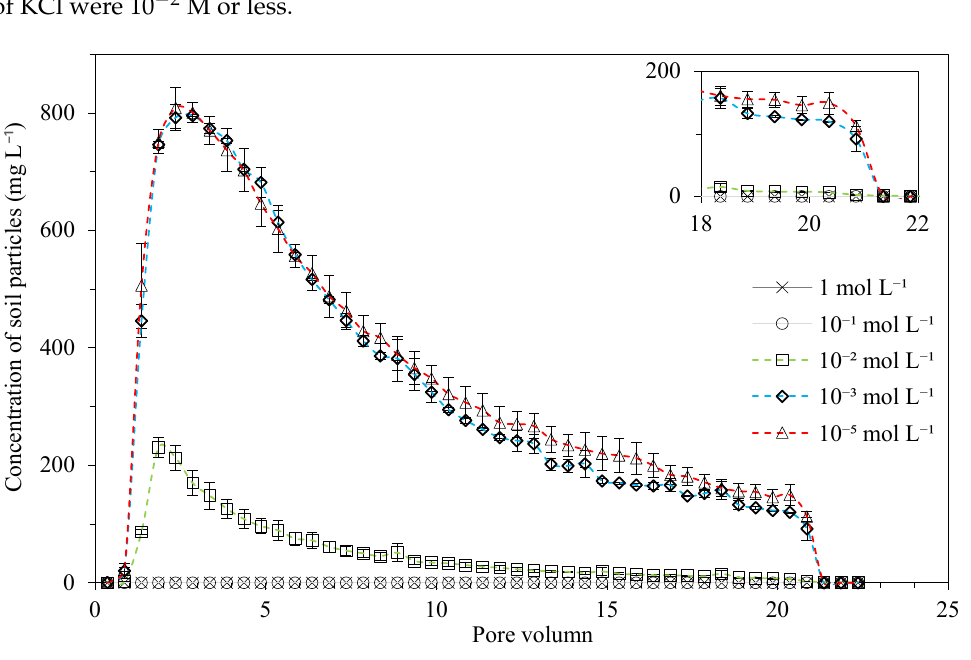
Figure 1. Effluent concentrations of soil particles under different electrolyte concentrations. The concentrations of the released soil particles rapidly increased and then